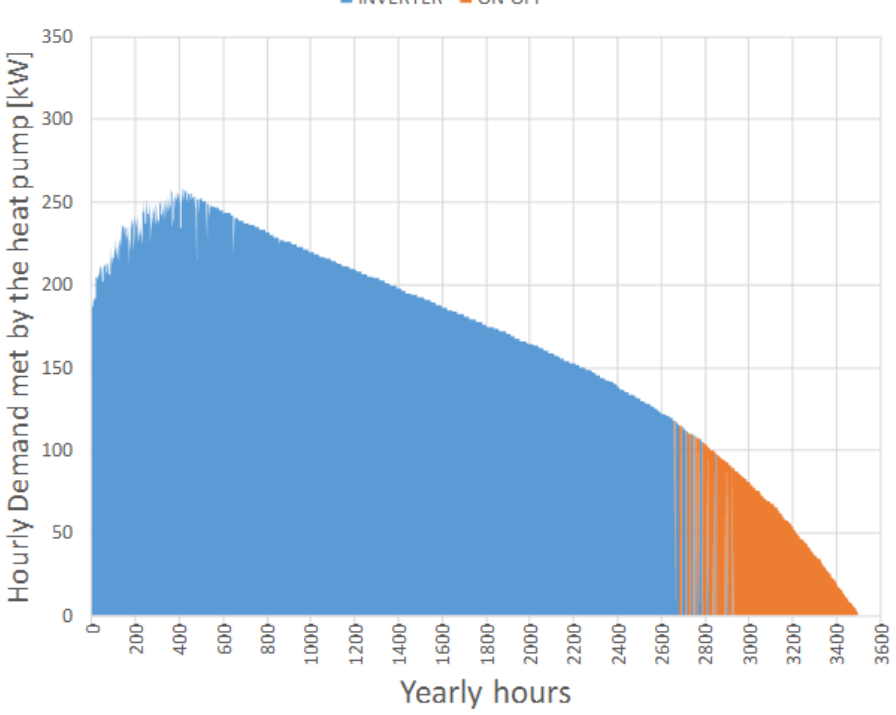
Figure 10. Thermal demand met by the heat pump at inverter control mode and on / o ff